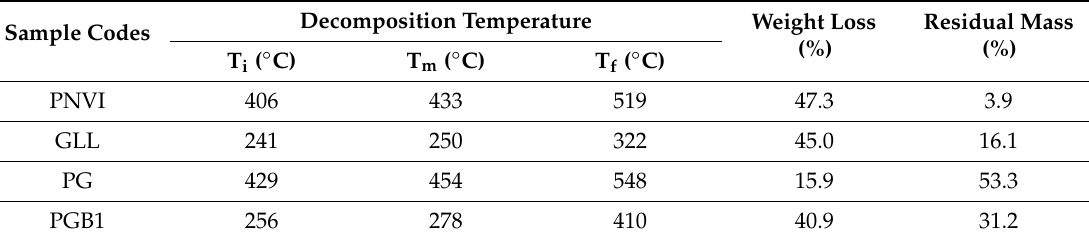
Table 1. Thermogravimetric analysis data for main stage of decomposition.